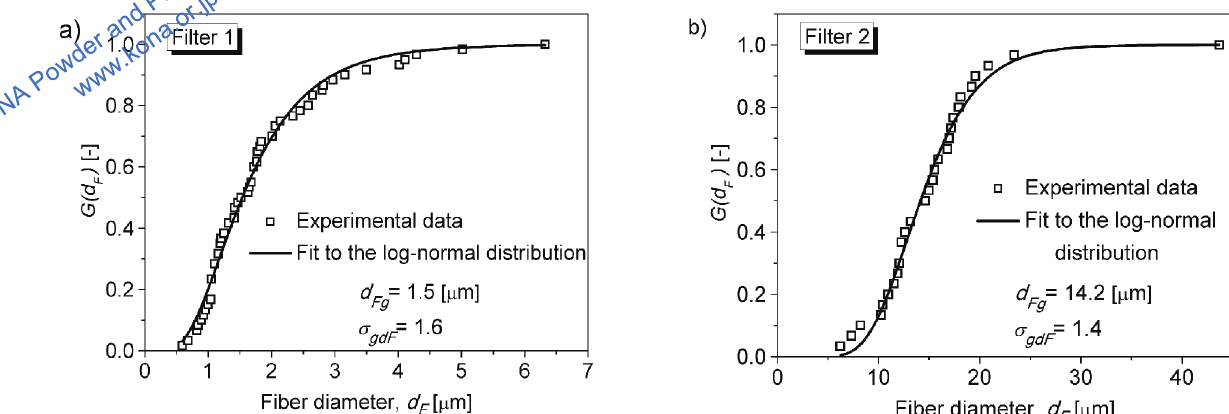
Fig. 3 Fiber size distributions of Filter 1 (a) and Filter 2 (b).